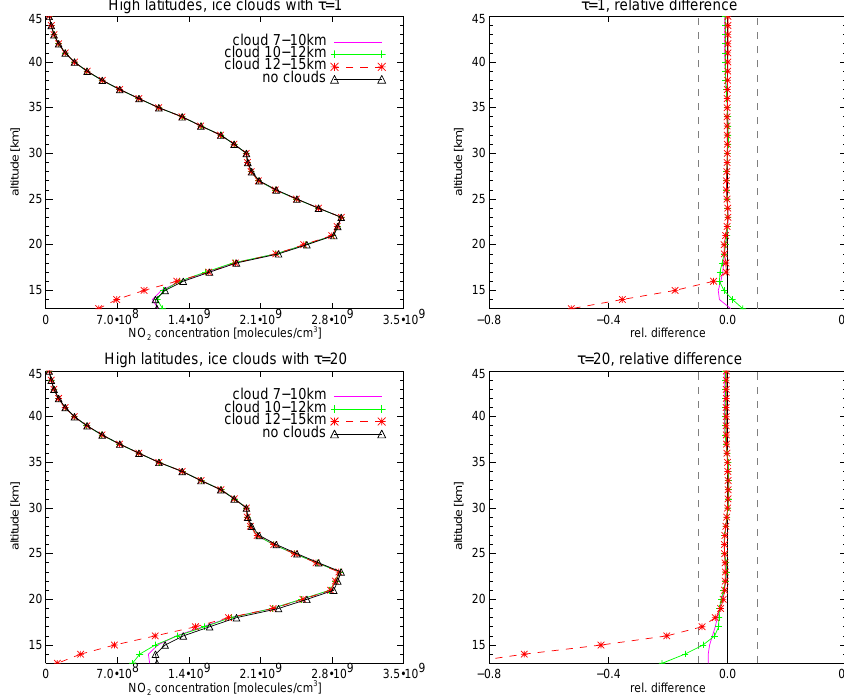
Fig. 7. Same as Fig. 6, but for ice